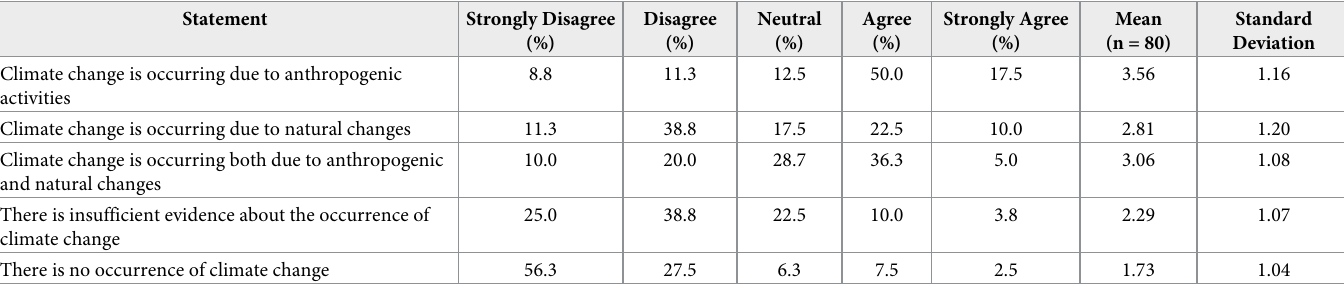
Table 2. Frequency distribution of climate change beliefs of the